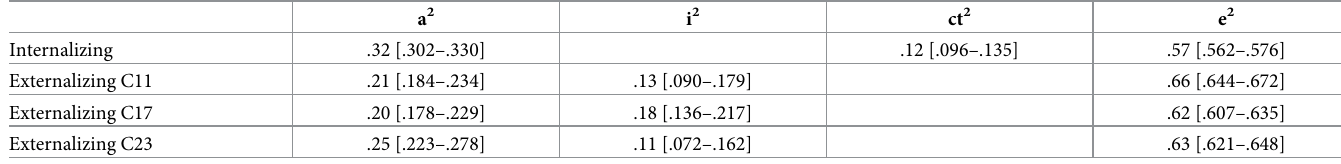
Table 5. Standardized variance components (final